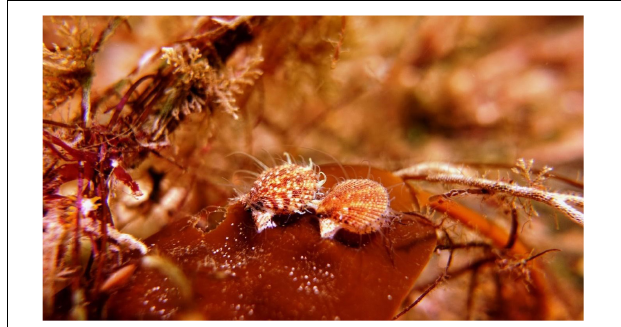
FIGURE 6 | Juvenile queen scallops ( Aequipecten opercularis ) have settled on and attached to this kelp frond within the Lamlash Bay NTZ. Complex three-dimensional habitats such as these are essential for the early life history survival of many marine species, including commercially valuable species such as scallops and gadoid fish. Photo: Howard